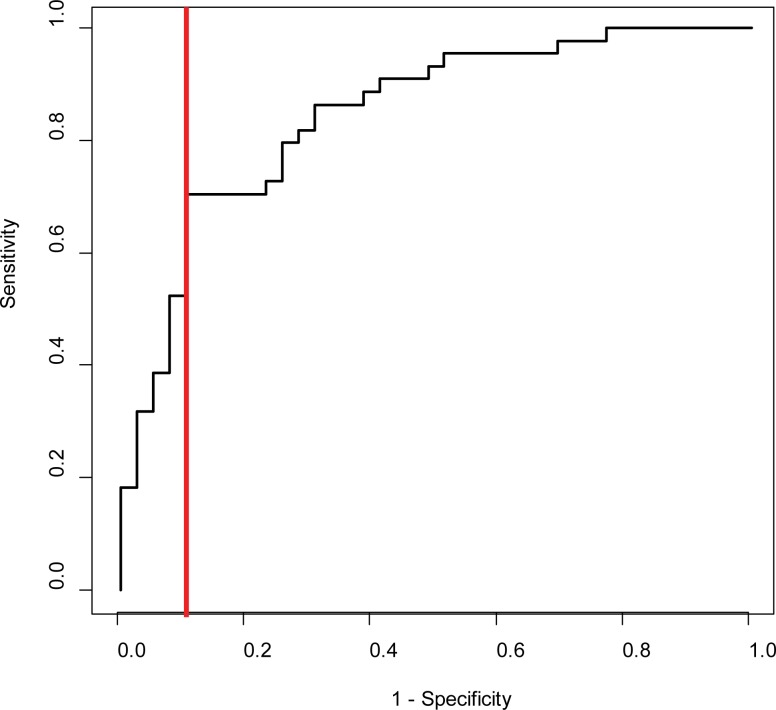
ROC curve for the prediction of treatment non-response based on admission log10 CRP adjusted for baseline FEV1% predicted.As can be seen from the ROC curve, a CRP cut-off of >75 mg/L corresponds to a test specificity of 90% and sensitivity of 70%.